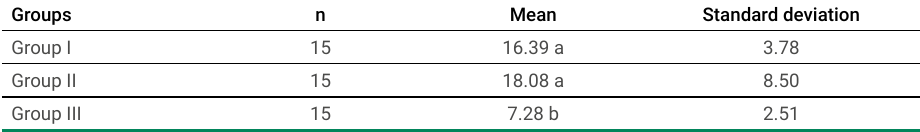
Table 1. Descriptive statistics in Megapascals (MPa) of shear bond strengths of experimental groups studied